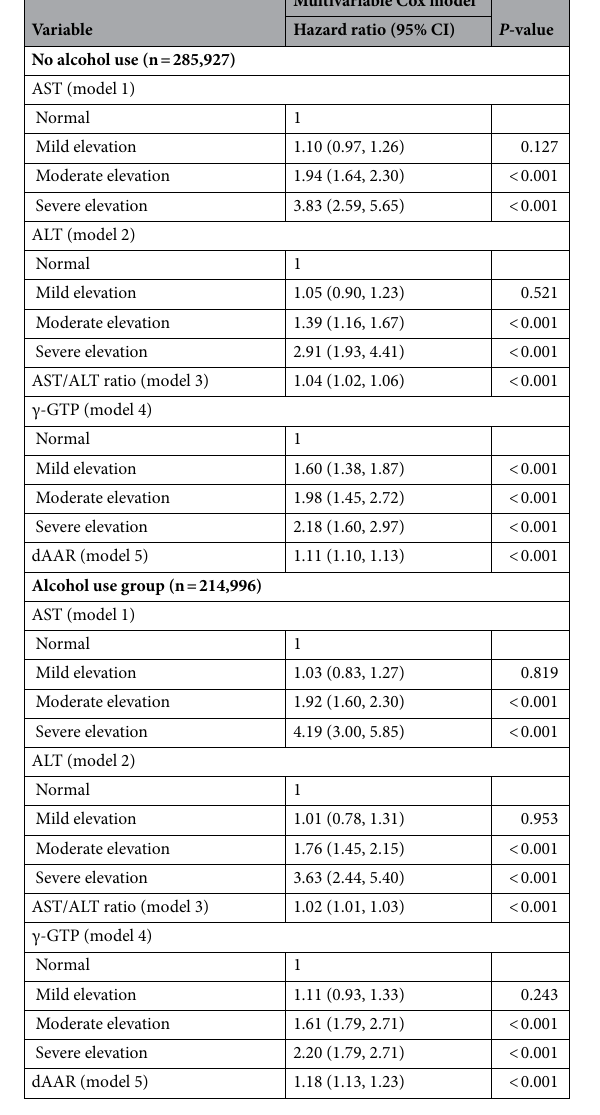
Table 4. Subgroup analyses according to alcohol consumption. CI, confidence interval; AST, aspartate transaminase; ALT, alanine aminotransferase; γ-GTP, γ-glutamyl